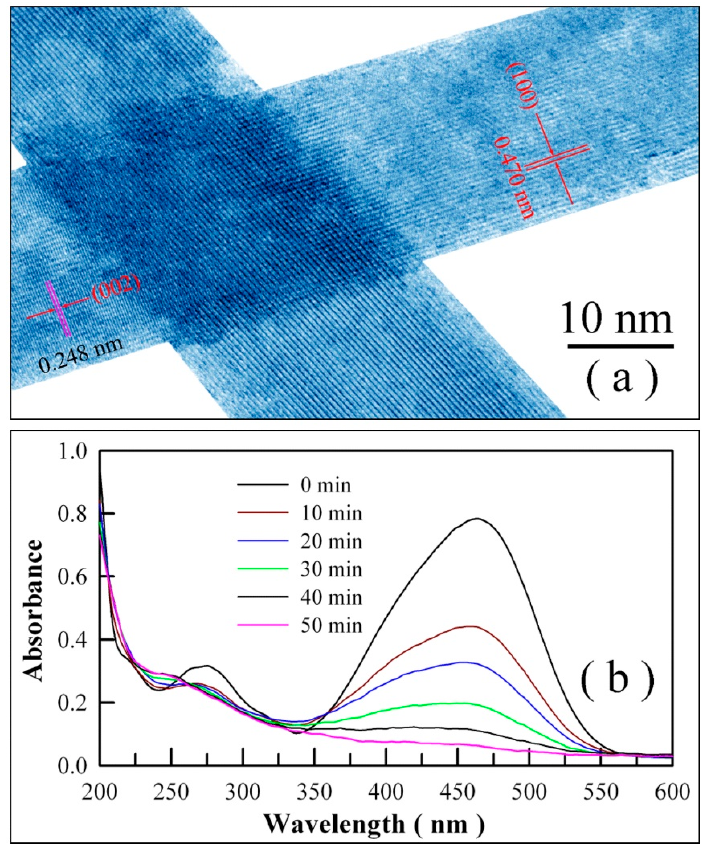
Figure 17 ( a ) High-resolution TEM micrograph of one ZnWO 4 nanoplate with a {010} facet; ( b ) absorption spectra of methyl orange solution as a function of UV irradiation time in the presence of ZnWO 4 nanoplates with a {010} facet.